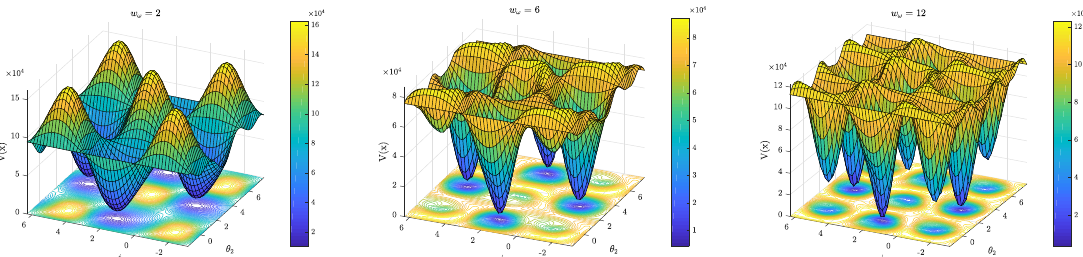
Figure 2. Shape of the cost function V ( x ) for a motion with simultaneous planar rotations of the segments. The parameters θ 1 and φ 1 are fixed near their true values and θ 2 and φ 2 are allowed to vary. From left to right, we see how the geometry changes as w ω increases while w a = 1 is constant. As w ω increases, new local minima appear near the locations at φ 2 + π from the previously existing local minima. These new local minima correspond to the wrong sign pairing ( ± j 1 , ∓ j 2 )